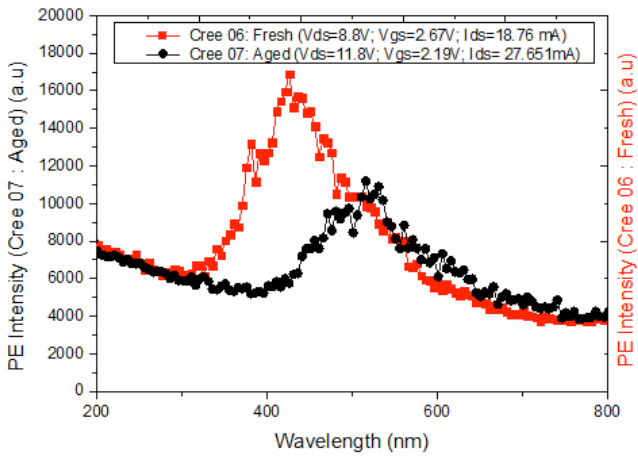
Fig. 11. PE spectrum of the fresh and the ESD aged devices Following the ESD stress, diffusion at this junction is suspected, which has generated an increase in leakage current, and has caused a spectral gap between the fresh and the degraded device. To confirm this hypothesis Nano-SIMS analyses will be